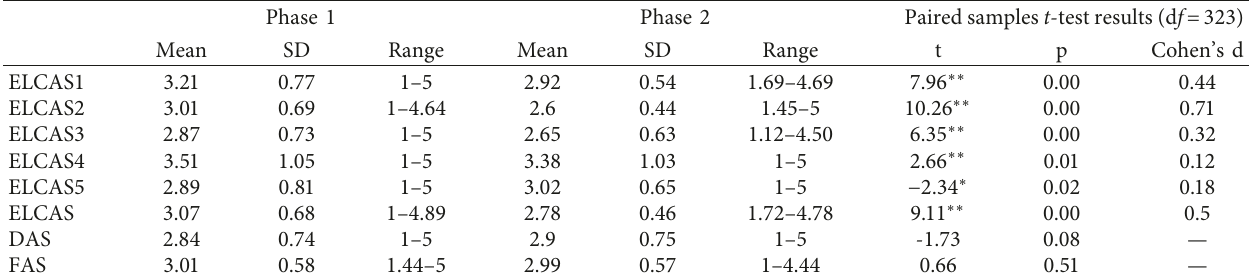
Table 6: Means and SDs of ELCAS and AAS scales in two phases ( N �